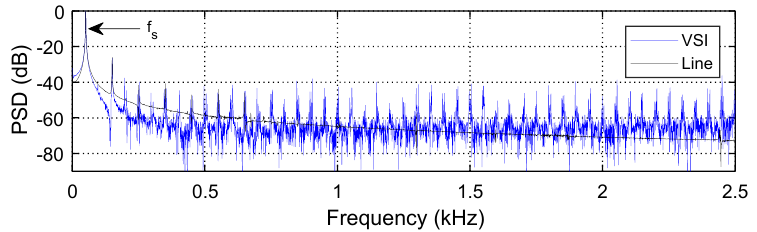
Figure 6. Spectra of the motor supply voltage when fed from the line or from the voltage source inverter and under stationary conditions.